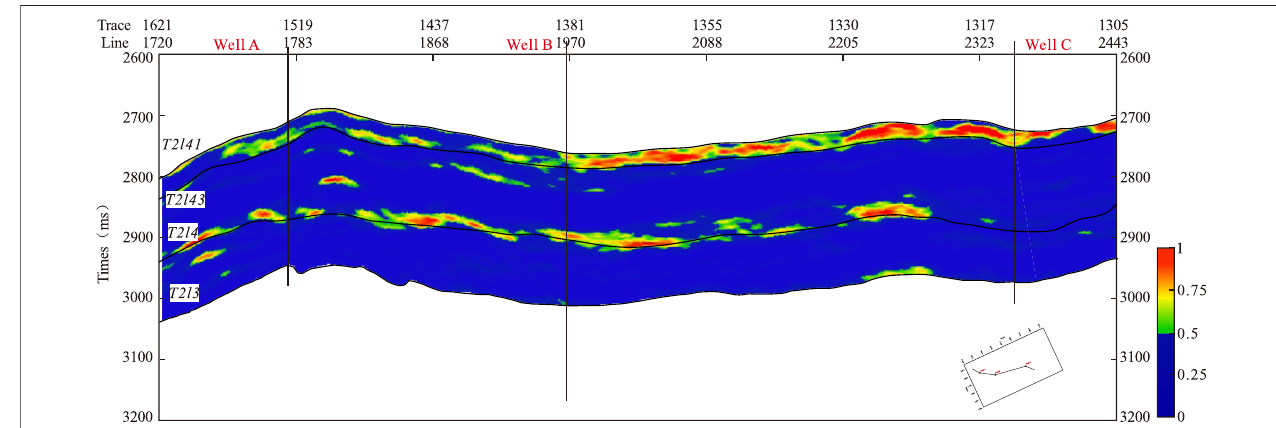
FIGURE 14 | DNN hydrocarbon detection